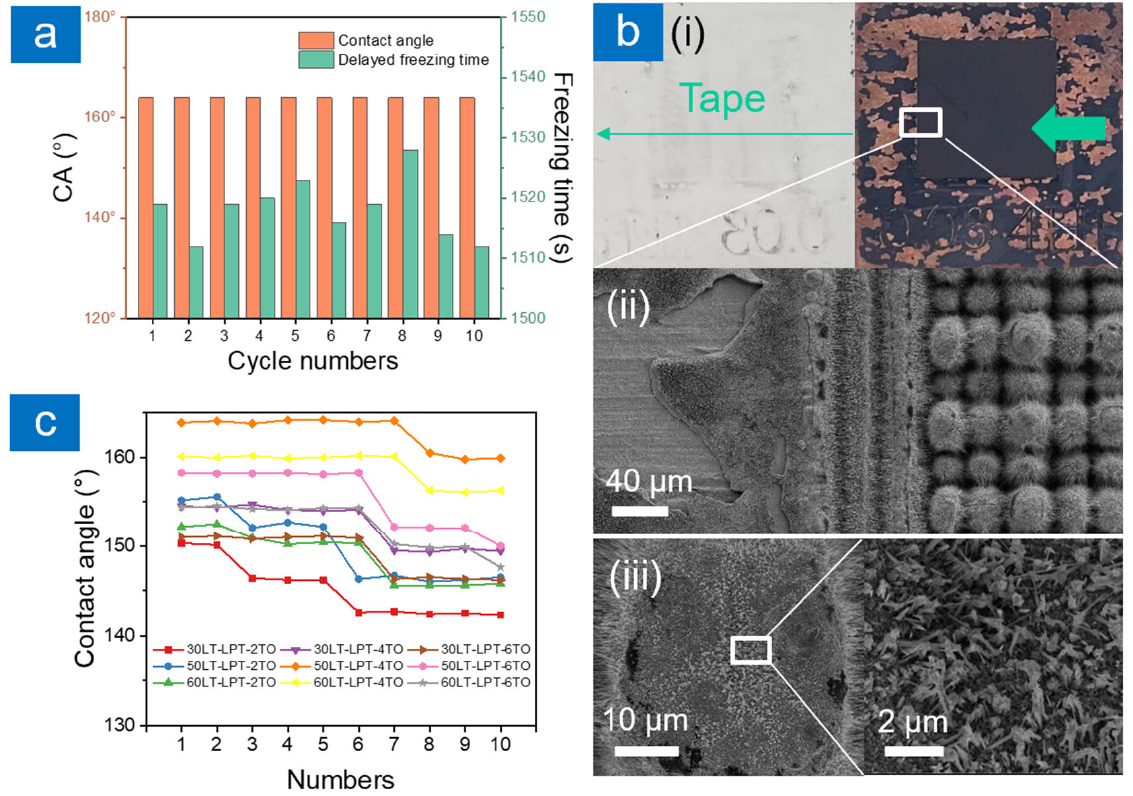
Figure 5. Durability tests. ( a ) Variations of wettability and anti-icing performance in icing–melting cycles for the 50LT–LPT–4TO sample. ( b ) Tape test: ( i ) optical microscopic image; ( ii , iii ) SEM images of the 50LT–LPT–4TO sample after 10 cycles. ( c ) Variation of contact angle with number of tape test cycles.